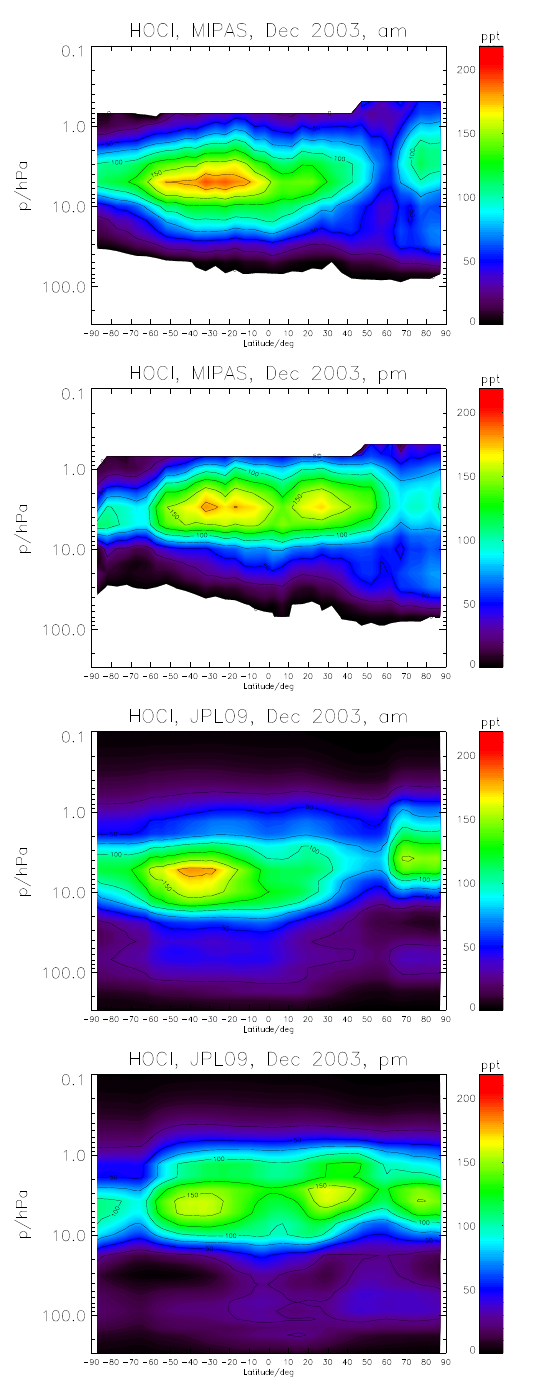
Fig. 7. Increased HOCl amounts in the southern (July 2002, evening, upper panel) and northern (January 2003, morning, second panel) polar winter stratospheric vortex subsequent to chlorine activation, together with related model calculations (third and fourth panel). Note that in the polar night the time of the day is of no concern .